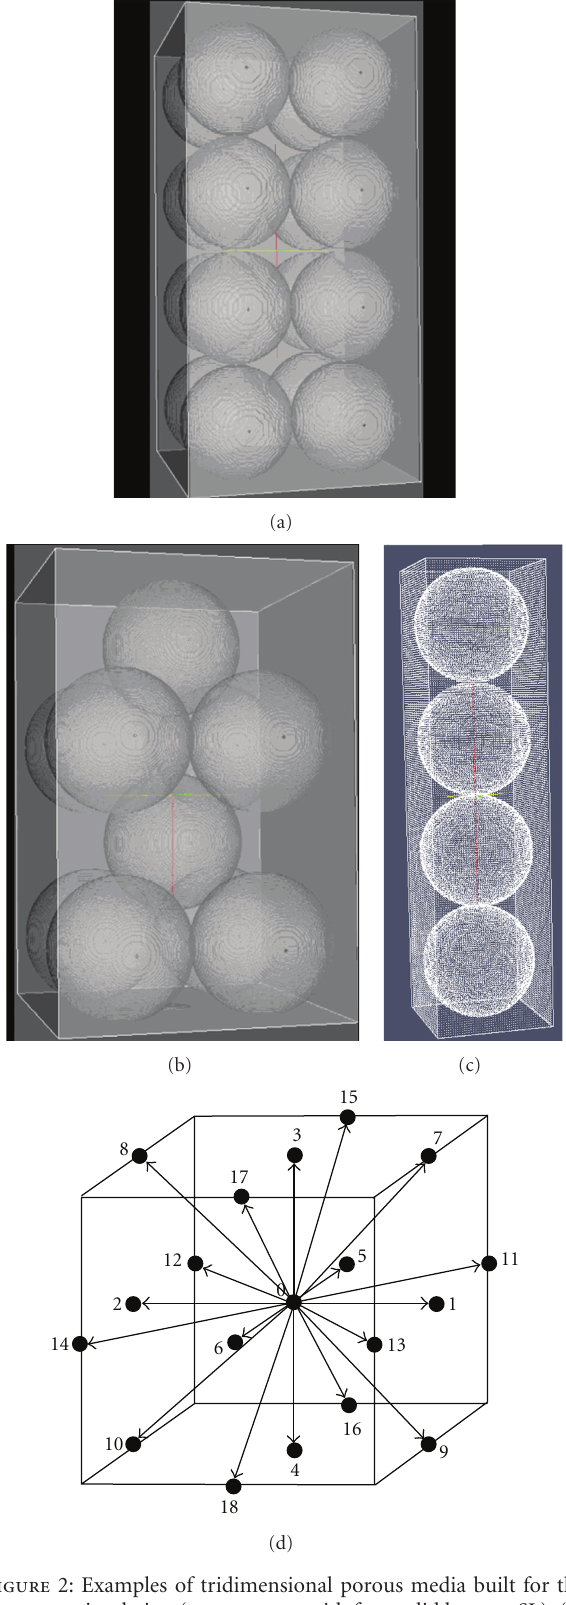
Figure 2: Examples of tridimensional porous media built for the computer simulation (arrangement with four solid layers—SL). (a) QQ; (b) QU; (c) OO and (d) direction vectors of the D3Q19 net site used in simulations